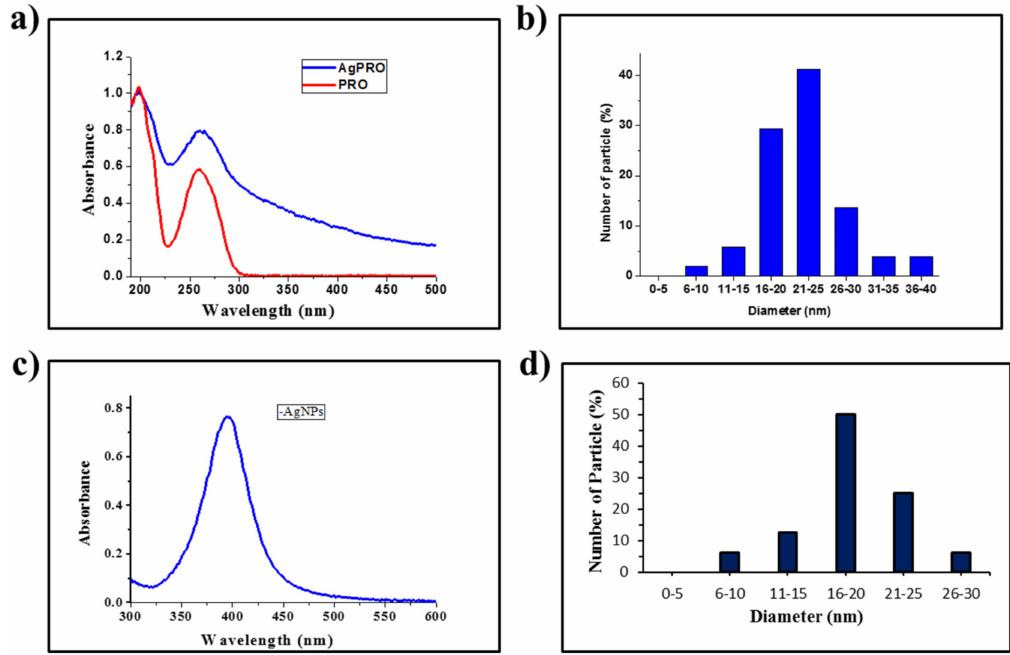
Figure 4. UV–Vis absorption spectra and particle size distribution of Ag(II)PRO nanoparticle ( a , b ) and AgNPs ( c , d